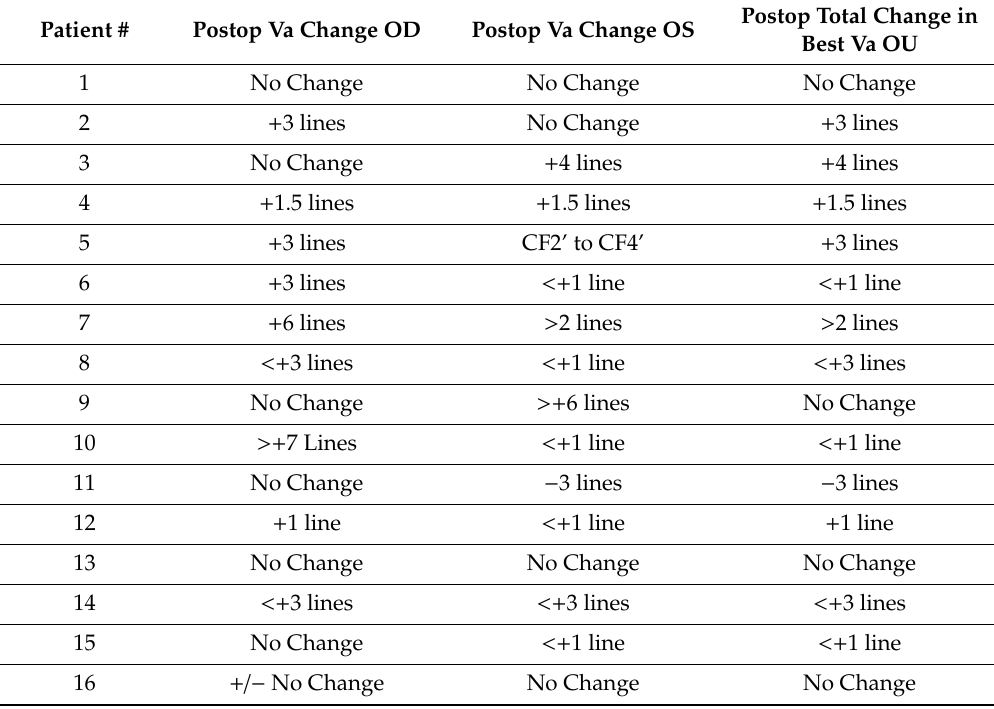
Table 2. Change in snellen lines of